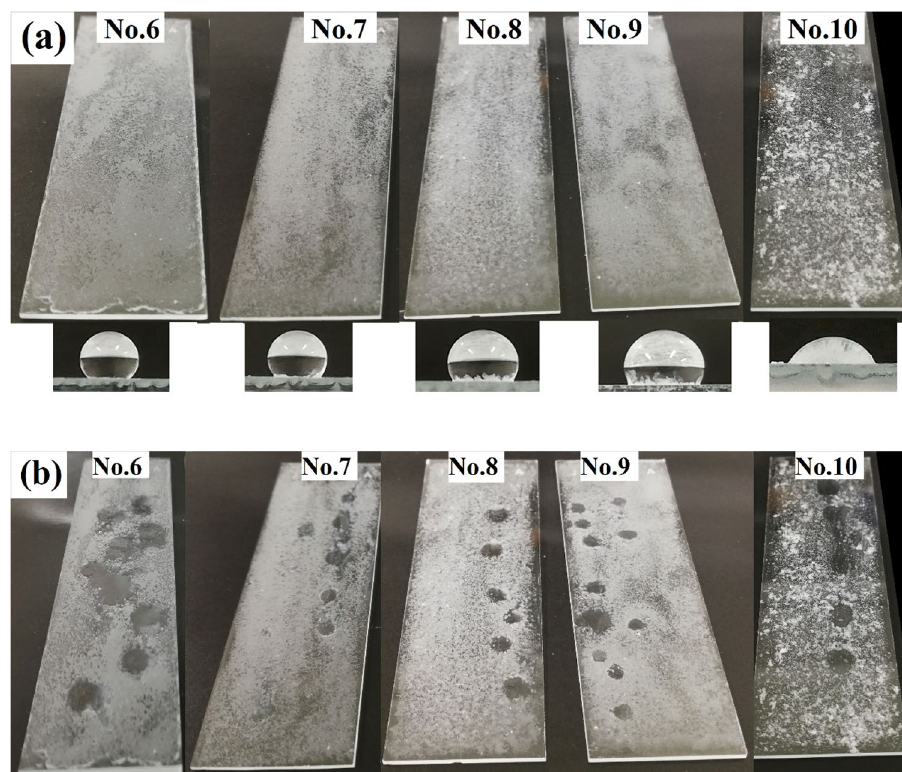
Fig. 3 Optical photographs of the coatings deposited on the glass slides by sliding of syringe of 0.5 ml coating solu- tions using the coating solu- tions prepared with various amounts of PAA (compositions No. 6 and 7) and various TEOS/ DDTMS ratios (Compositions No. 7 ~ 10) by the processing method III: a before and ( b ) after water repellent test using 10 μL water droplets. The lower images of Fig ( a ) were optical photographs of a 10 μL water droplet on the coating surface showing the water